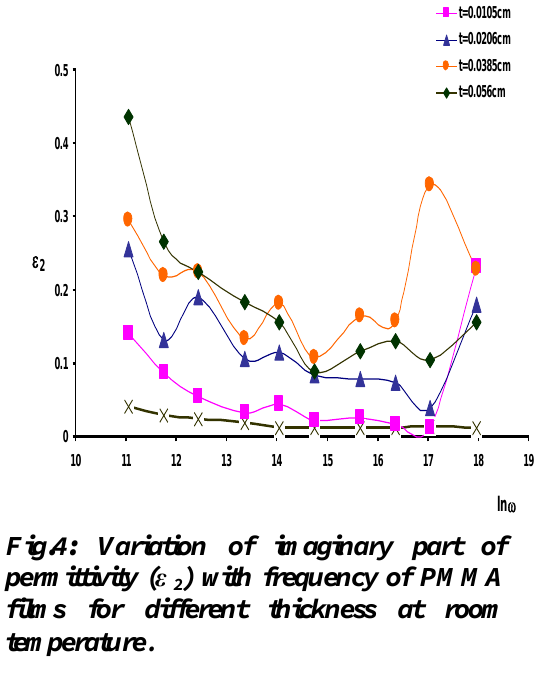
Fig.4: Variation of imaginary part of permittivity (ε ) with frequency of PMMA 2 films for different thickness at room temperature .